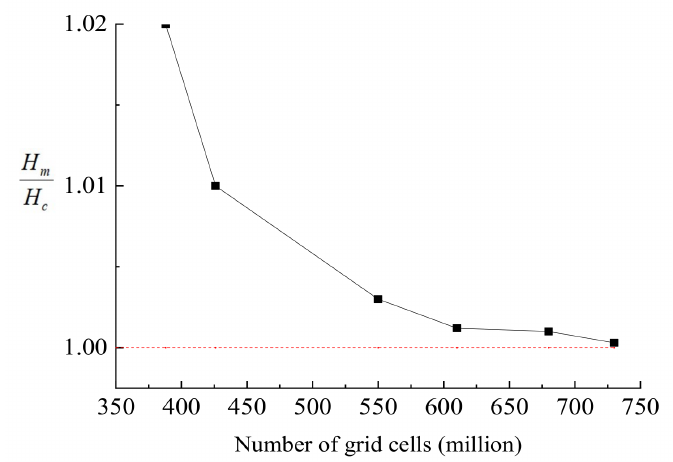
Figure 6. Mesh independence verification.